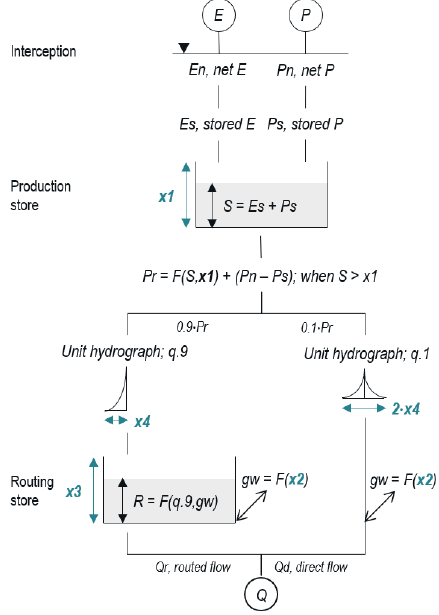
Figure A2. Structure of the GR4J hydrological model, based on Perrin et al. (2003). The five-parameter GR5J sees the addition of x 5, inter-catchment exchange parameter, at the same locations as x 2, whilst GR6J sees the addition of a store parallel, capacity x 6, to the routing